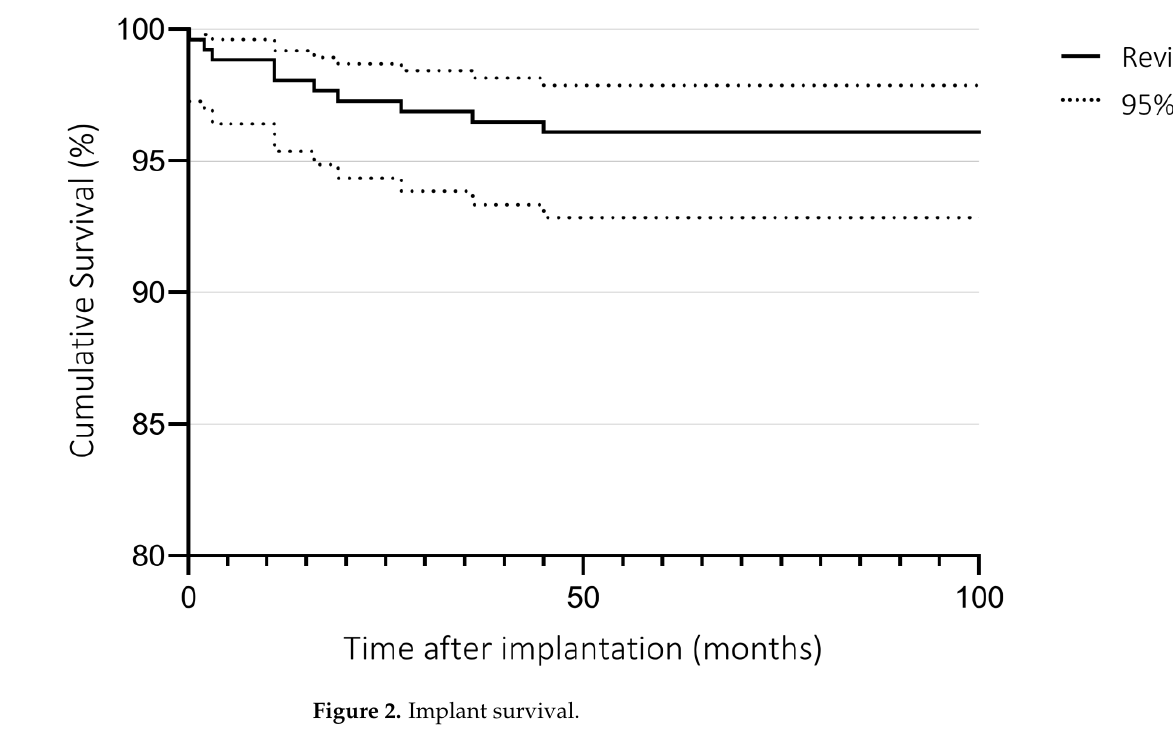
Figure 2. Implant Figure 2. Implant survival.